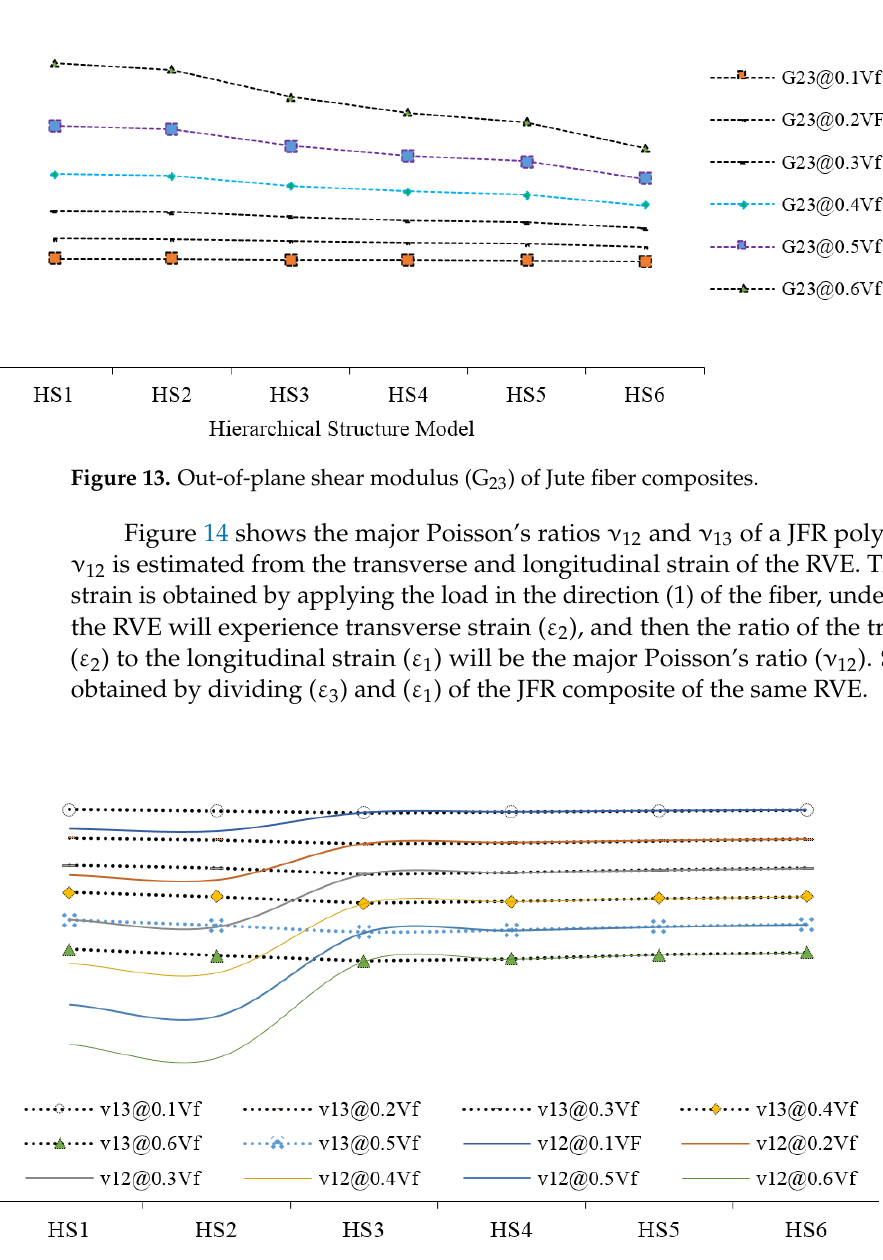
Figure 14. The major Poisson’s ration ( ν 12 and ν 13 ) of jute fiber reinforced composites. Compared with synthetic fiber composites, ν 12 and ν 13 are not the same for HS-1, HS-2 and HS-3 structured composites. The highest percentage of cellulose is responsible for this deviation in HS-1, HS-2 and HS-3 model structures. The largest lumen